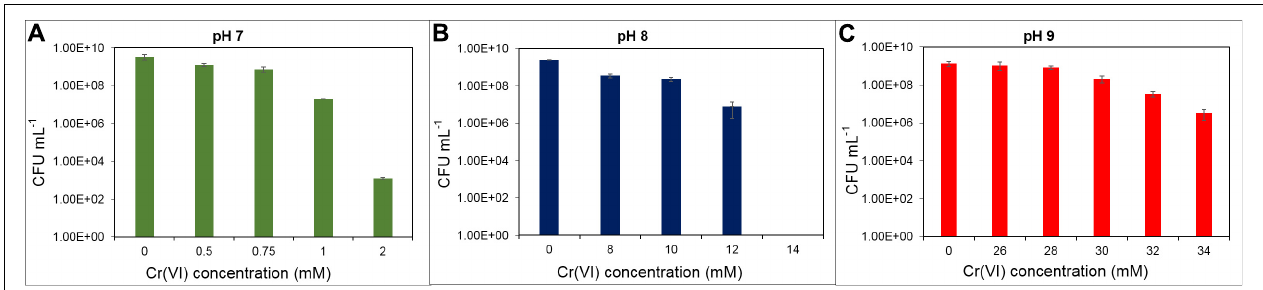
FIGURE 1 | Cr(VI) resistance as indicated by growth of Klebsiella sp. strain AqSCr in LB medium at different pH. (A) pH 7, (B) pH 8, and (C) pH 9.